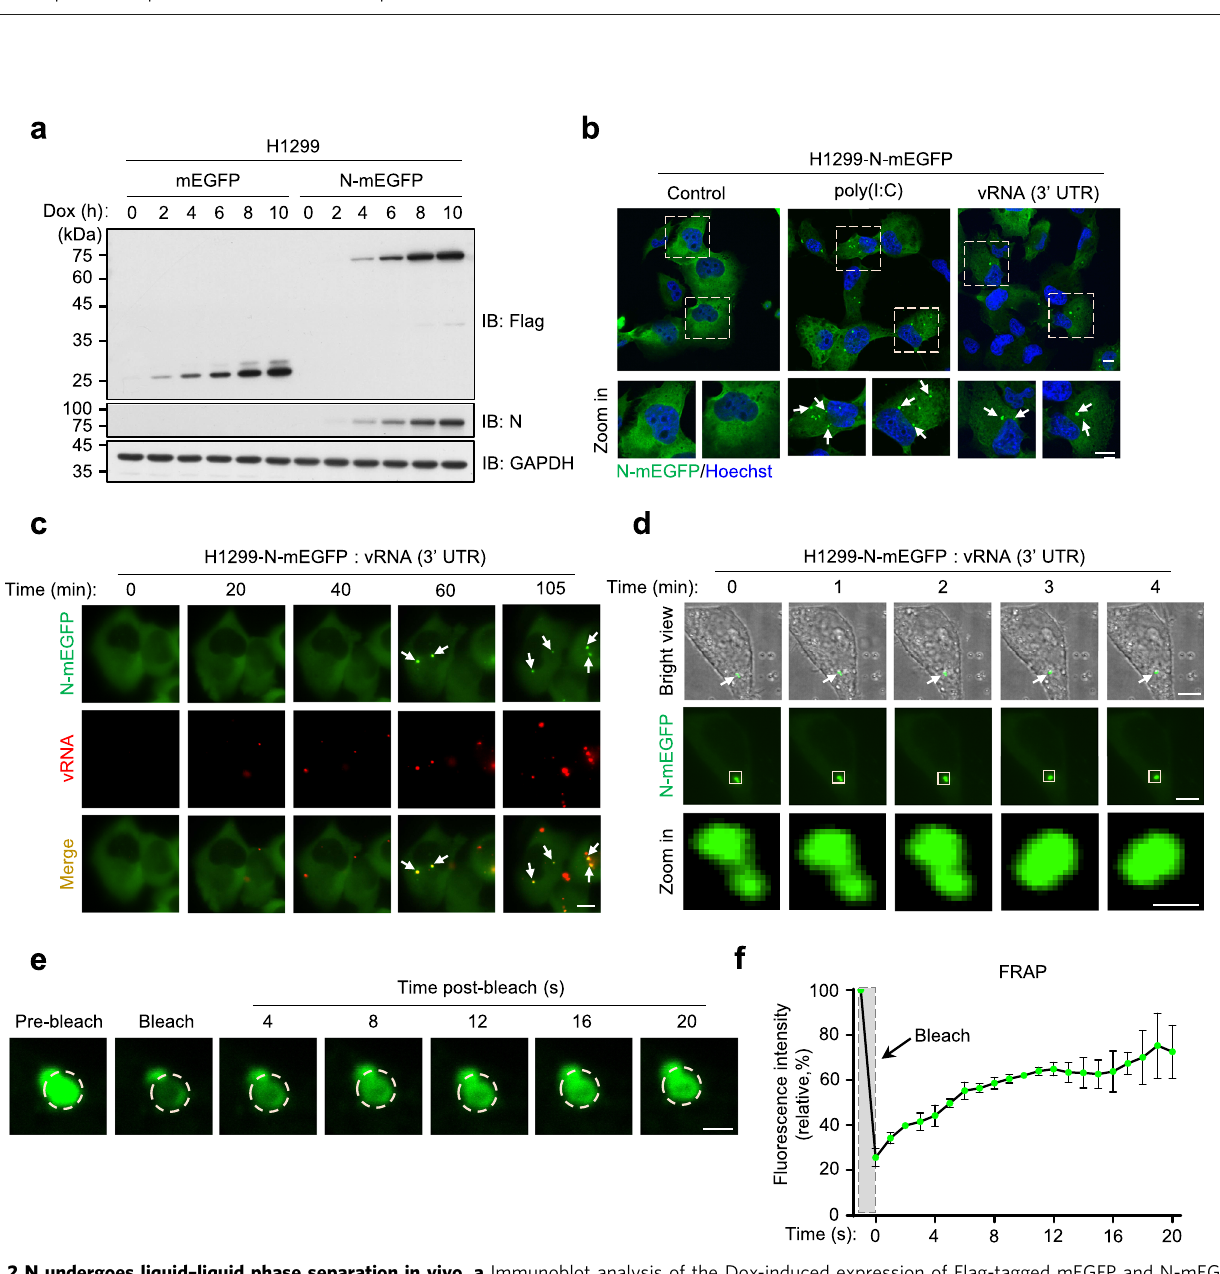
Fig. 1 RNA triggers the LLPS of N protein. a Schematic drawing of SARS-CoV-2. b IDR scores of 29 proteins encoded by SARS-CoV-2 genome. FUS and mEGFP are positive and negative controls, respectively. IUPred2 and ANCHOR2 were used as prediction tools. c Time-lapse imaging of N-mEGFP protein (20 μ M) in the presence of Cy5-labeled 60-nt vRNA (100 ng/ μ l), scale bar, 10 μ m. d Representative fl uorescent images of N-mEGFP-vRNA (60 nt) condensates fusion from a time-lapse movie, scale bar, 3 μ m. e – g LLPS of N-mEGFP protein (20 μ M) in the presence of indicated concentrations of 60-nt vRNA, scale bar, 10 μ m ( e ). The partition coef fi cient of fl uorescence intensity per droplet ( f ) and the partition coef fi cient of total fl uorescence intensity in each view ( g ) were calculated. From left to right, n = 209, 1170, 1026, 1170 droplets ( f ) from 10 randomly selected views ( g ). h , i FRAP analysis of vRNA- induced liquid droplets of N-mEGFP protein, scale bar, 2 μ m ( h ), and quanti fi cation of fl uorescence intensity recovery of a photobleached N-mEGFP protein, n = 3 biologically independent experiments ( i ). The white dotted circle in h indicated the region of photobleaching. 20 μ M N-mEGFP protein and 100 ng/ μ l 60-nt vRNA were used. Error bars, mean with s.d. ( f , g , i ). Two-tailed unpaired Student ’ s t -test ( f , g ), **** P < 0.0001. Data are representative of at least three independent experiments. Source data are provided as a Source Data fi